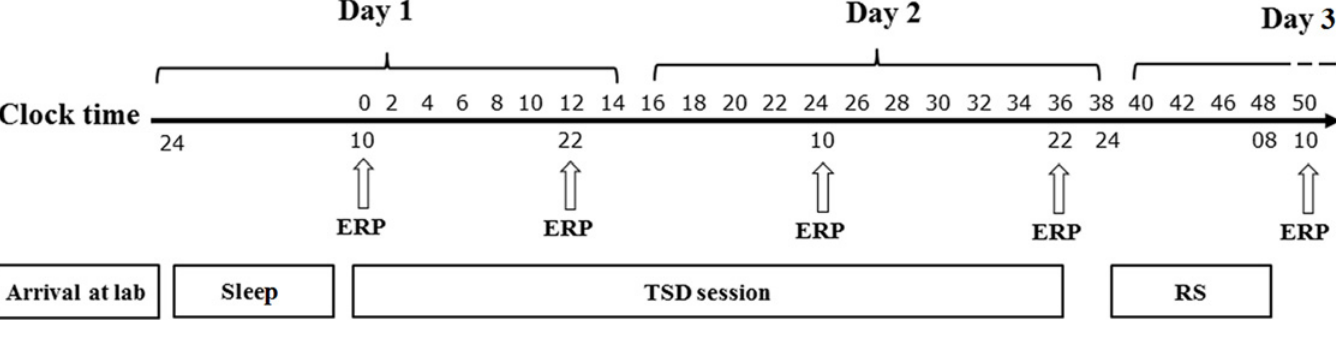
PLOS ONE | DOI:10.1371/journal.pone.0142361 December 10,